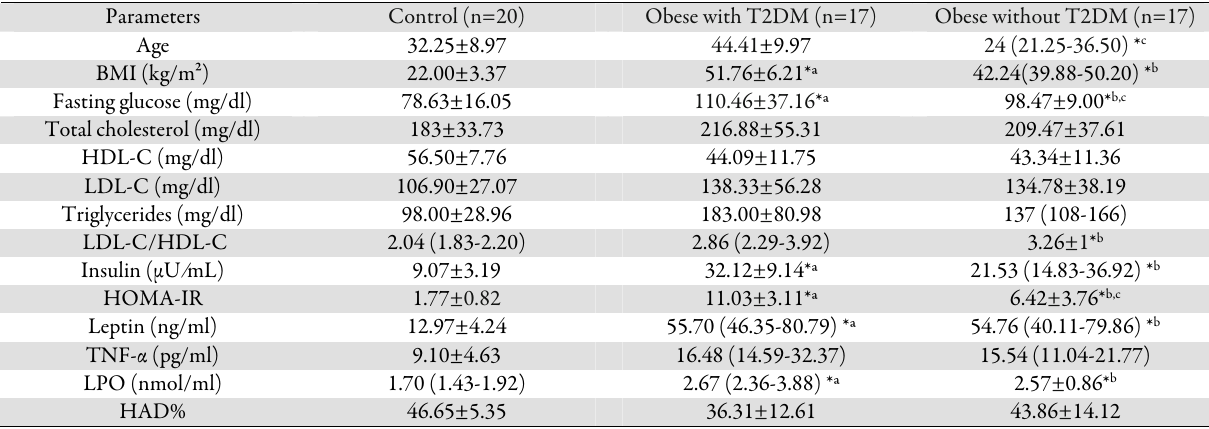
Tab. 2. Anthropometric and laboratory characteristics of the